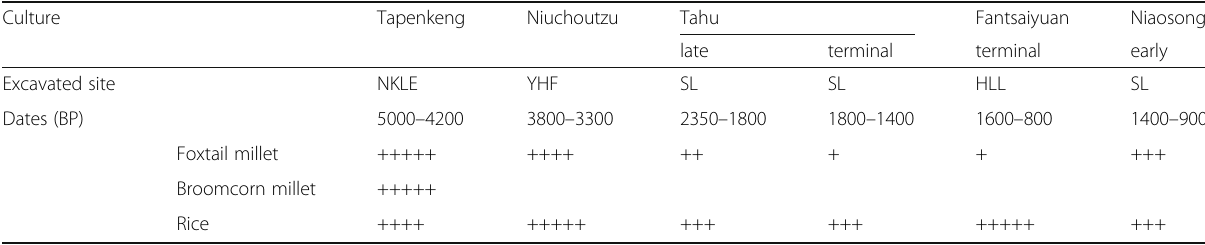
Table 1 Long-term persistence of rice-and-millet agriculture in Taiwan Culture